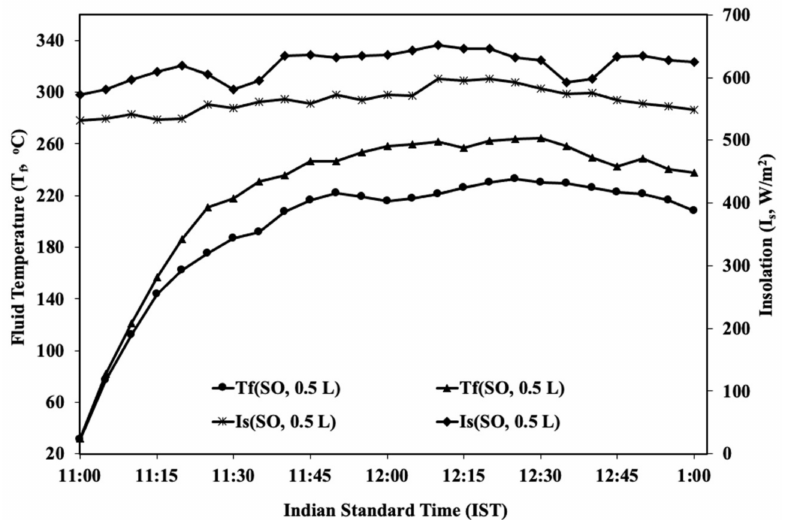
Figure 8. Variation of solar insulations ( I S ) and average fluid temperatures ( T f ) with Indian standard time (IST) for SO of capacity 0.5 L (20 November 2021) and 0.5 L (09 November